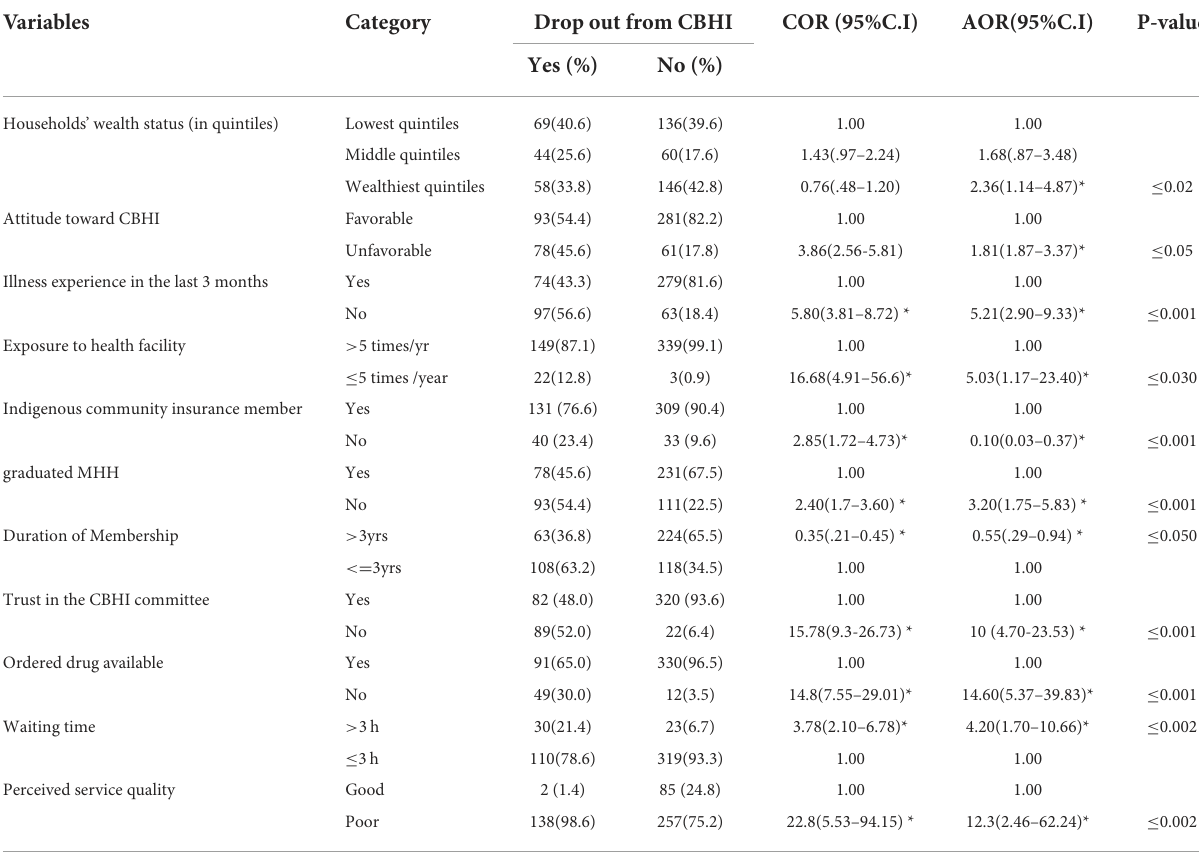
TABLE 3 Factors influencing dropout of HH from CBHI membership adjusted for confounding variables, in rural districts of Gurage Zone, Southwest Ethiopia,2021 ( n = 513).